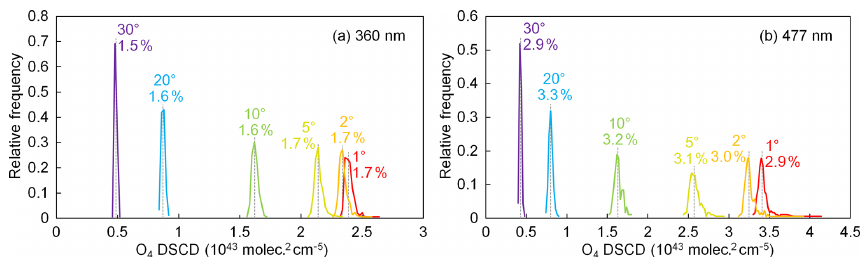
Figure B3. Frequency distribution of O 4 DSCDs at (a) 360nm and (b) 477nm simulated with all the phase functions during 2013–2014. The other simulation parameters followed the settings listed in Table B1. The percentage standard deviations of the simulated O 4 DSCDs at each elevation angle are labeled in the plots. The grey dashed lines represent the median values of simulated O 4 DSCDs at each elevation angle.